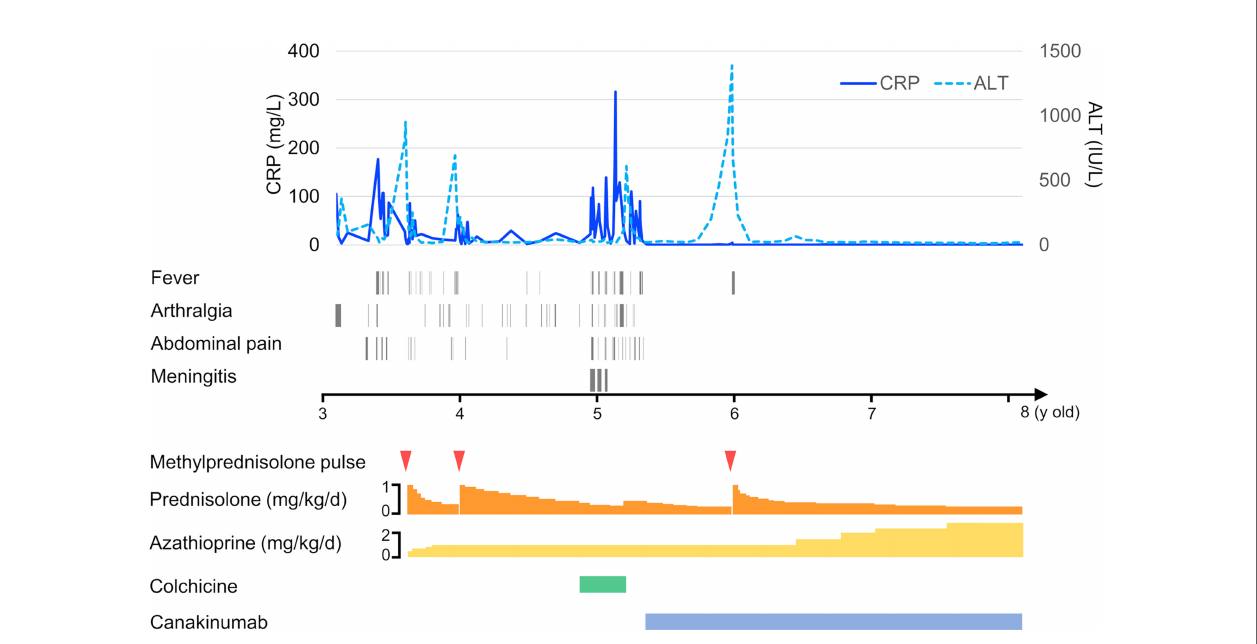
FIGURE 3 | Timeline of the case exhibiting hematological testing, symptom presentation, and